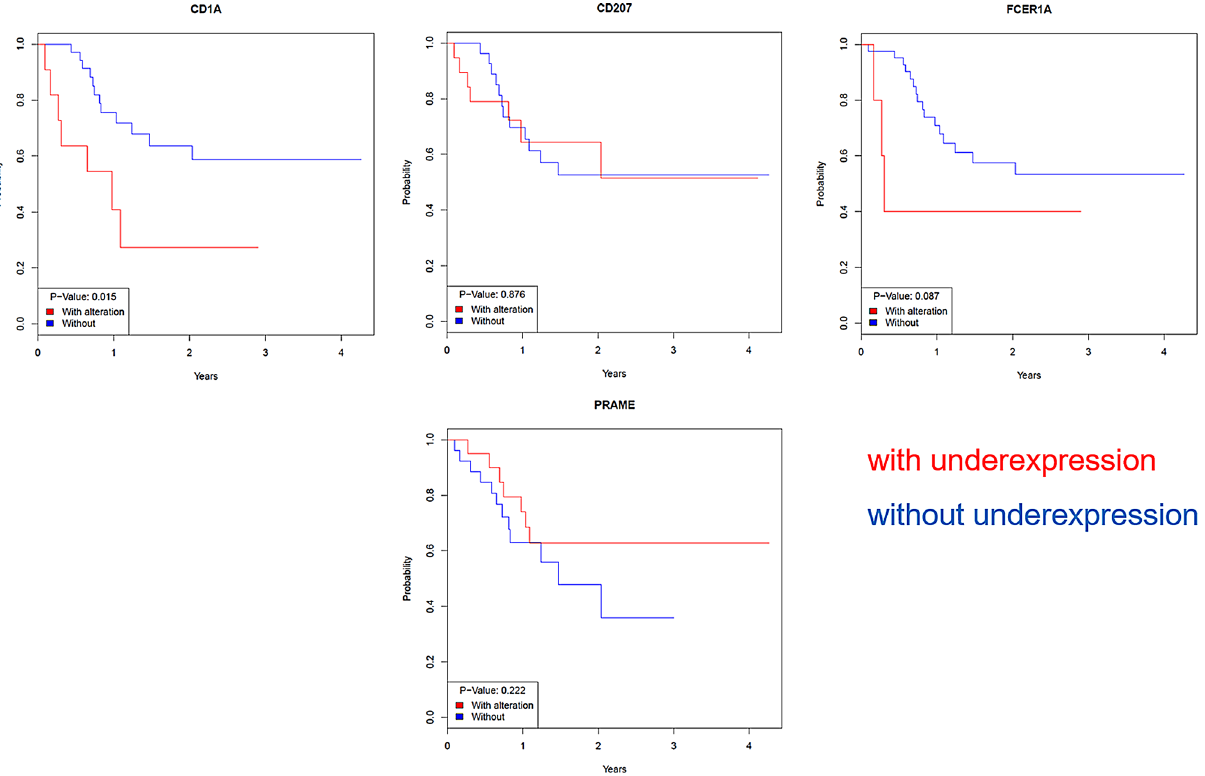
Figure 3. Correlation of mRNA expression of the four identified candidate genes CD1A, CD207 , FCER1A and PRAME with clinical outcome of the patients (time to post-surgical relapse) using Kaplan-Meier estimator. Underexpression is defined as foldchange < −2 compared to mean expression of all reference